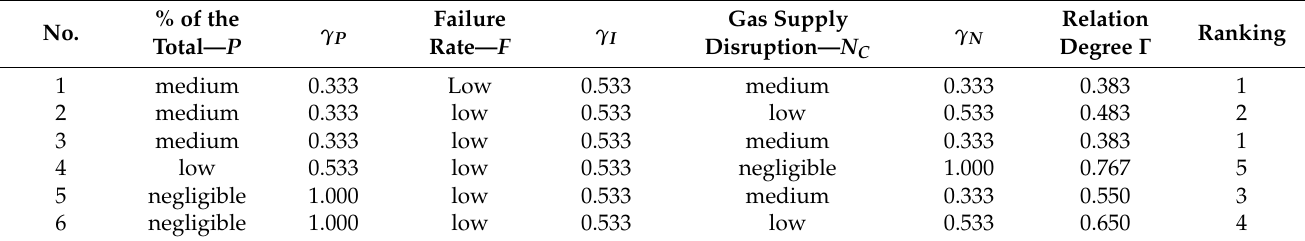
Table 2. Undesirable events